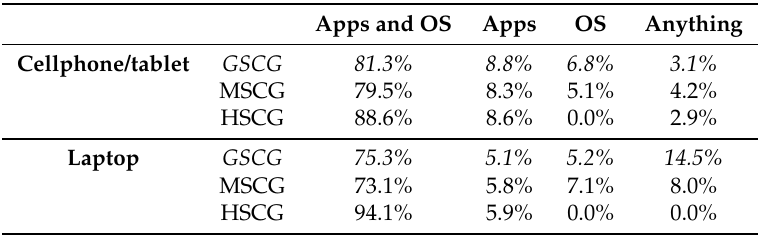
Table 4. Do you regularly update the software on your mobile